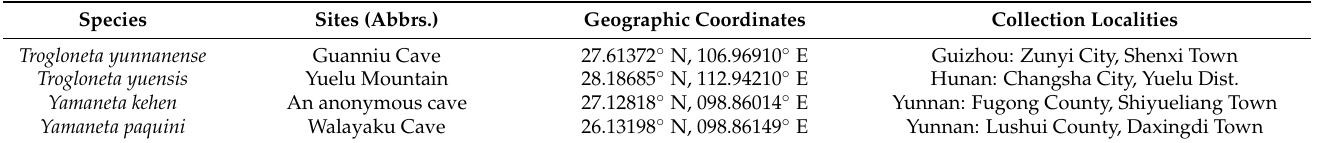
Table 1. Information of spider samples and localities. Species Sites